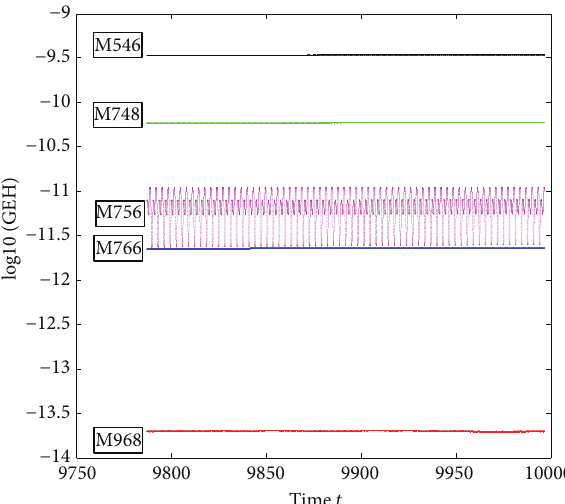
Figure 3: Errors of the Hamiltonian function of (23) on [0, 10000] , with ℎ = 𝜋/300 . Figure 4: Errors of the Hamiltonian function of (26) on [0,10000] , with ℎ = 𝜋/300